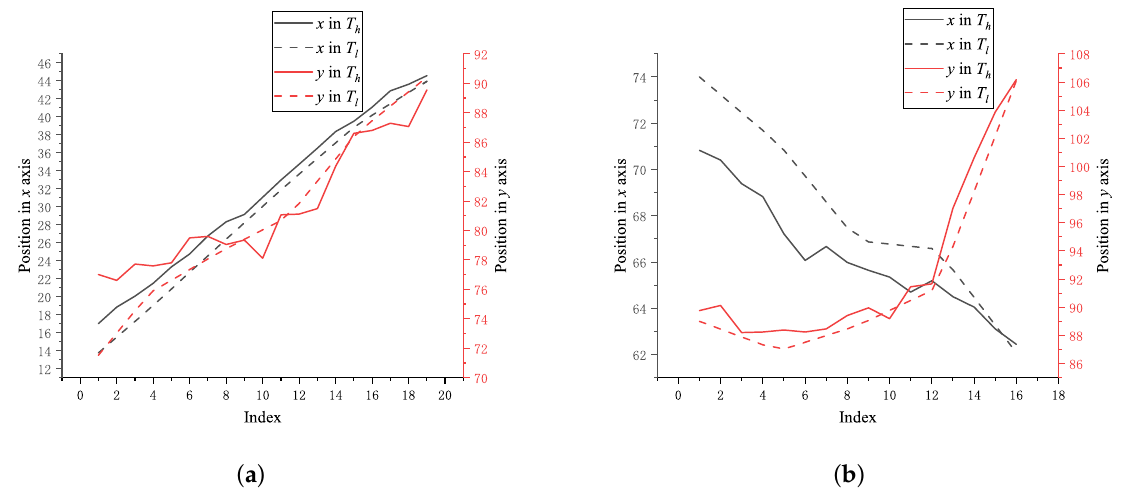
Figure 11. ( a ) Neighbor feature trajectories at f l and f h in C 1 with ρ lh = 0.9598; the horizontal ordinate Index represents the i th point in this optical flow trajectory, i ∈ [ 1, n ] . ( b ) Neighbor feature trajectories at f l and f h in C 2 with ρ lh =